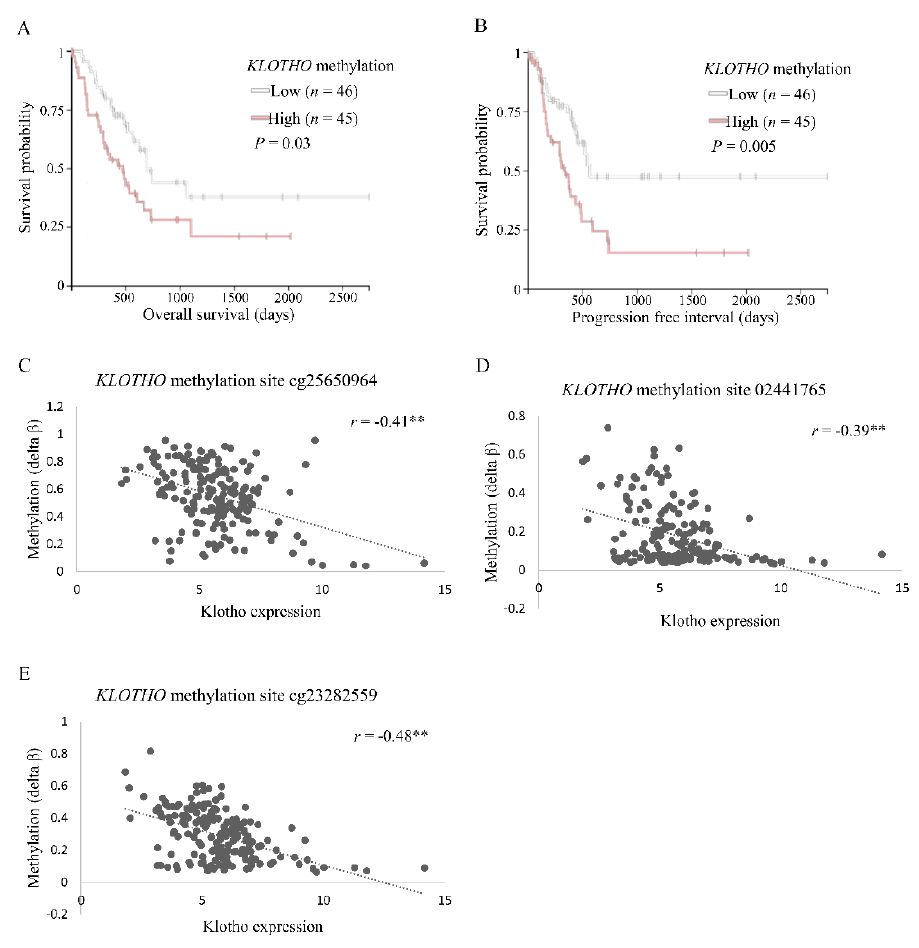
Figure 2. KLOTHO is hypermethylated in pancreatic cancer. ( A – E ) The UCSC Xena Browser was used to examine TCGA PAAD cohort. ( A , B ) RNA Methylation450k dataset was analyzed for overall survival and progression-free interval of patients with tumors showing low (<0.5152, n = 46) vs. high (>0.5830, n = 45) KLOTHO methylation. ( C – E ) Gene expression RNAseq (IlluminaHiSeq) and RNA Methylation450k datasets were analyzed for correlation between klotho expression and methylation at the indicated methylation sites ( n = 178). ** p < 0.005. r , Pearson ’ s correlation coefficient.